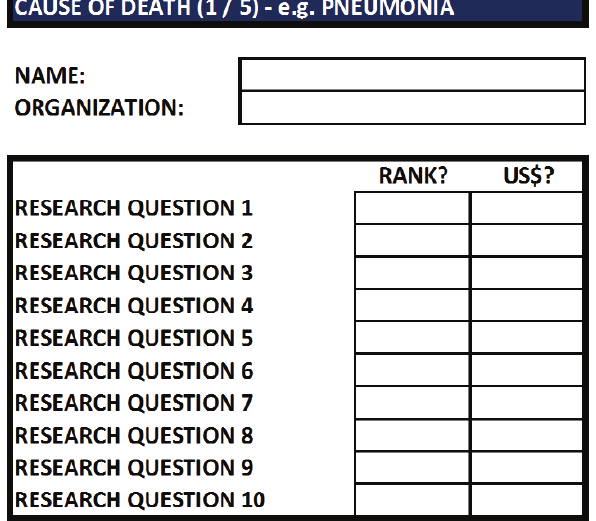
Figure 1. A questionnaire that was given to 16 funder represen- tatives at the meeting to obtain information useful to under- standing funding attractiveness of different research